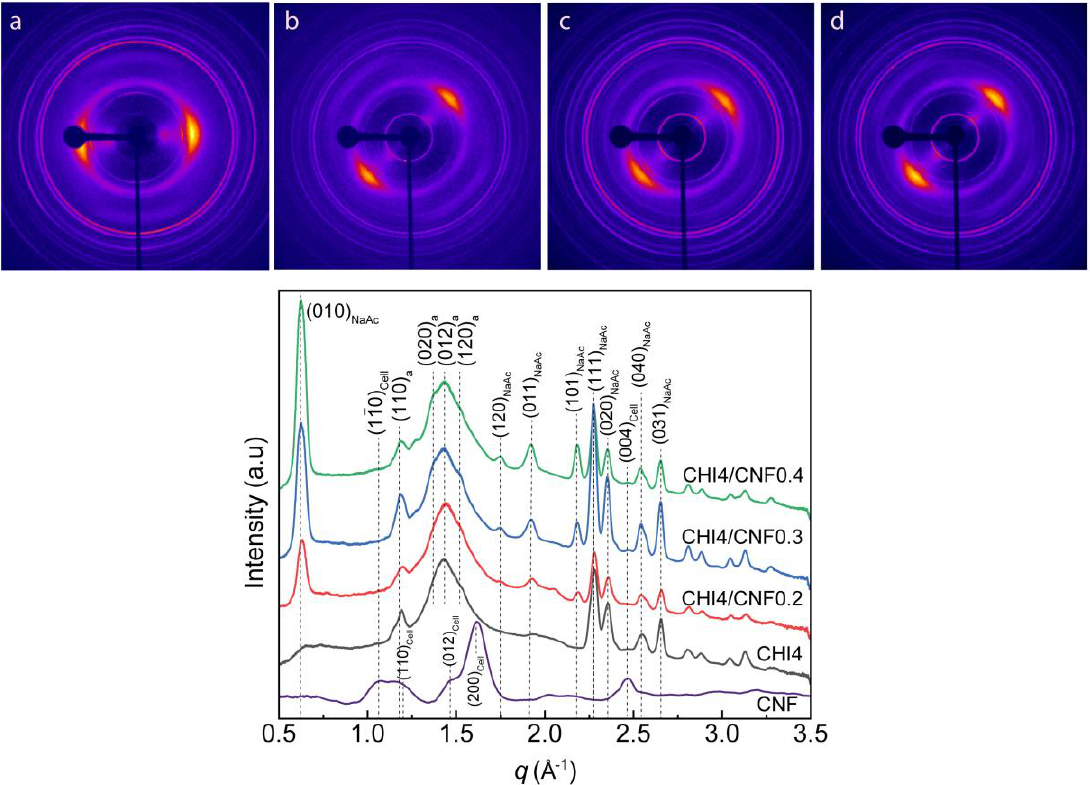
Figure 7. ( Top ) Two-dimensional wide-angle X-ray scattering (2D-WAXS) images of the spun CHI/CNF fibers of ( a ) CHI4, with vertical fiber axis; ( b ) CHI4/CNF0.2, ( c ) CHI4/CNF0.3 and ( d ) CHI4/CNF0.4 with fiber axis tilted by − 45 ◦ from the vertical position. ( Bottom ) Radial average over the 360 ◦ azimuth of the above 2D-WAXS images of spun fibers of varied CHI/CNF compositions. In the peak indexations, the notations “a”, “Cell”, and “NaAc” refer to the corresponding reflections of chitosan anhydrous polymorph, cellulose I allomorph, and sodium acetate salt crystals,